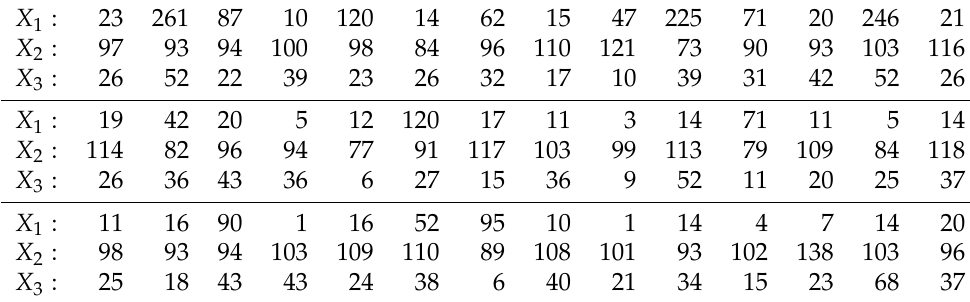
Table 2. Drinking water pumps trivariate data measured in the Sahel with n =